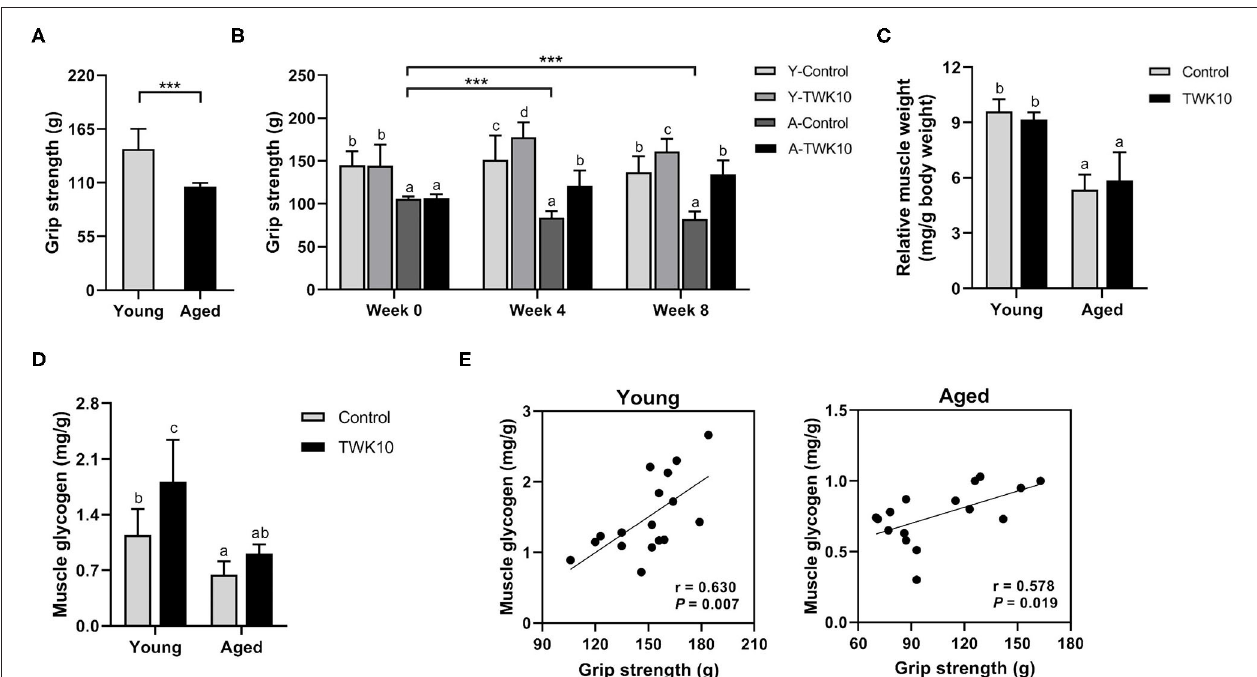
FIGURE 1 | Lactobacillus plantarum TWK10 attenuated the age-related decline in skeletal muscle strength by improving muscle quality. (A) Forelimb grip strength of young ( n = 17) and aged mice ( n = 16) was measured before administration. (B) Mice were treated with Lactobacillus plantarum TWK10 or PBS for 8 weeks, and forelimb grip strength was measured at week 0, week 4, and week 8. (C,D) Gastrocnemius muscles were harvested and subjected to measurements of muscle wet weight and glycogen levels. Data are represented as mean ± SD. Statistical differences among groups were analyzed by two-way ANOVA with the post-hoc Tukey-Kramer test. Different letters (a, b, c) indicate significant differences among groups, P < 0.05. Two group comparison was analyzed using the unpaired Student t -test. *** P < 0.001. (E) Pearson’s correlation, after 8 weeks of TWK10/PBS administration, between grip strength and muscle glycogen levels in the young and aged